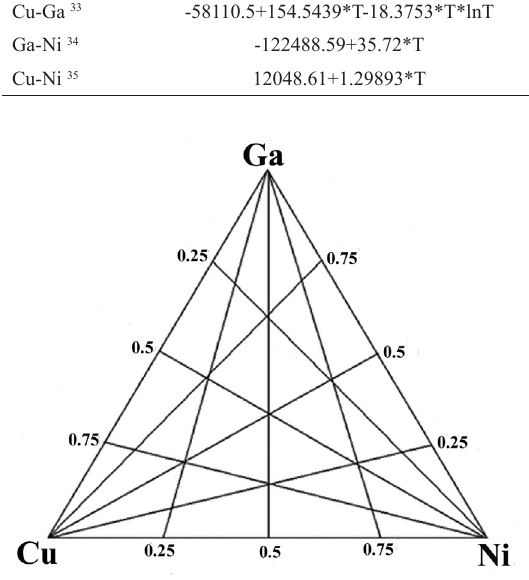
Table 1: Redlich-Kister parameters for constitutive binary systems (in J/mol) System ij